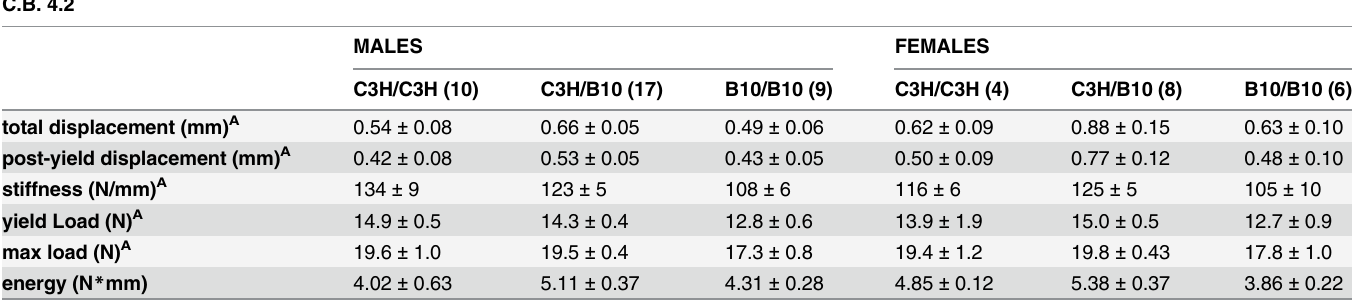
Table 6. Whole-Bone Mechanical Performance of C.B.4.2 Mice.